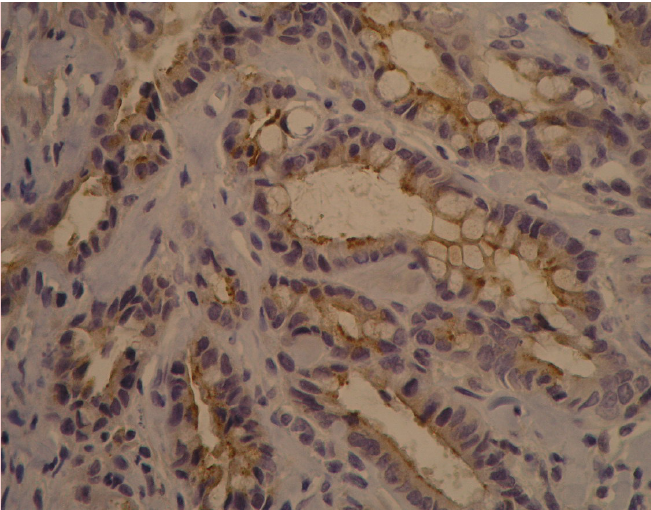
FIGURE 4 – Photomicrograph of a well-differentiated adenocarcinoma. Fine brown-stained cytoplasmic pigmentation. Positive for COX-2 (two-staged polymer technique, 400x)